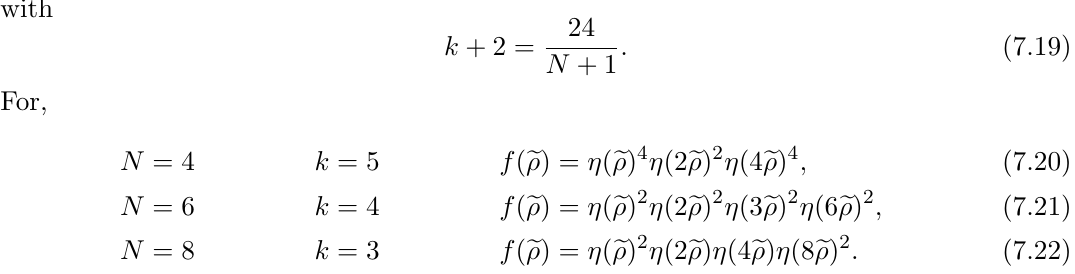
Table 3 . Frame shapes for Z N orbifolds of T 4 (cid:2) S 1 (cid:2) e S 1 . Note that P numbers give eta-quotients for the function f (